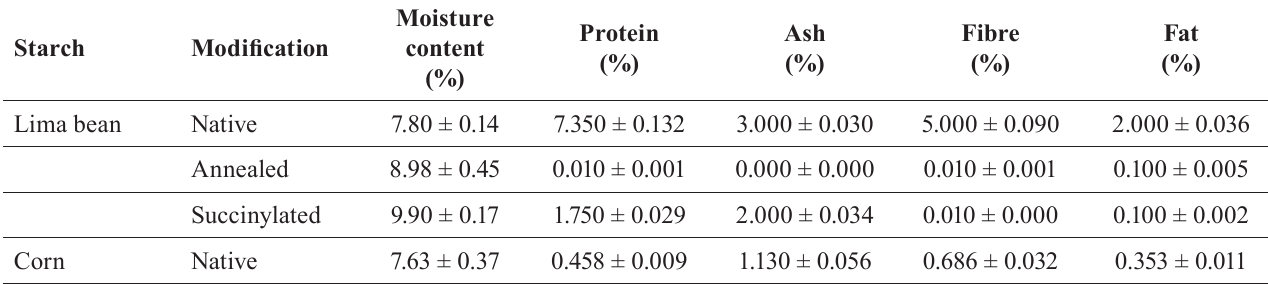
TABLE I - P roximate Composition of the starches